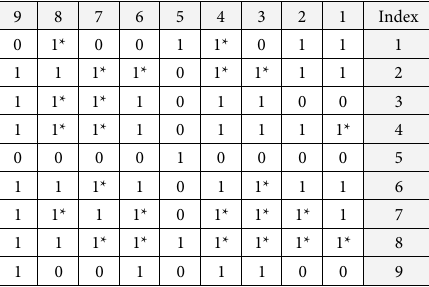
Table 8. Determining the Relationships and Leveling of